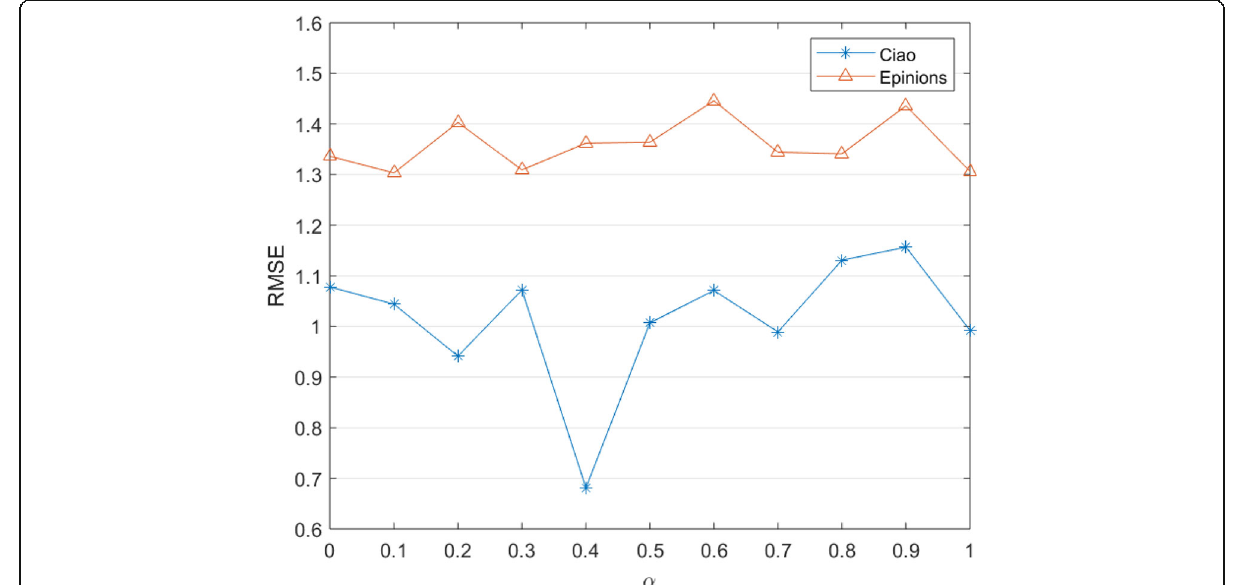
Fig. 7 RMSE vs. α on Ciao and Epinions. The blue line for Ciao, and the green line for Epinions